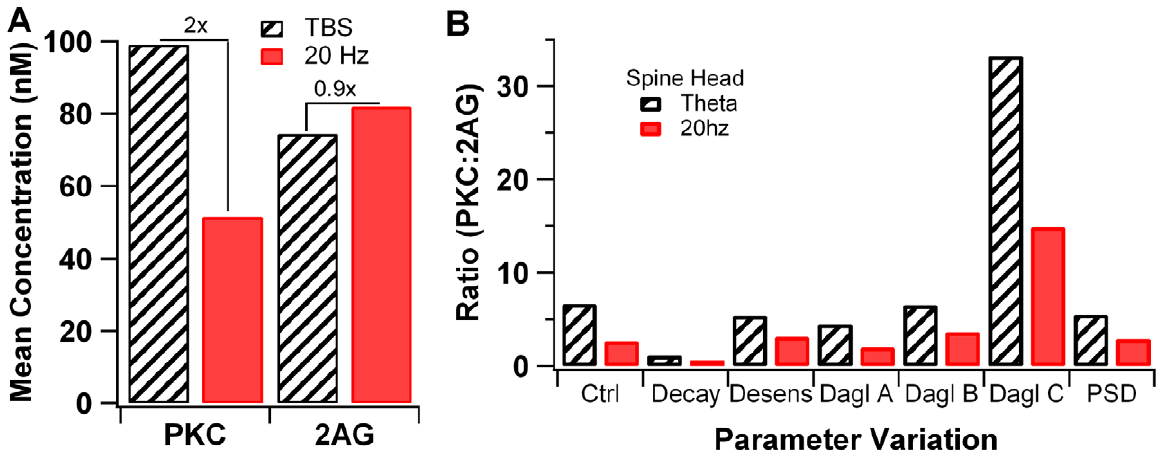
Figure 7. Summary of active PKC and 2AG production in response to theta burst and 20 Hz stimulation. (A) PKC is greater for theta burst stimulation than for 20 Hz stimulation, but 2AG is similar. Thus, the ratio of PKC to 2AG is greater for theta burst stimulation than for 20 Hz stimulation. (B) The enhanced ratio of PKC to 2AG for theta burst stimulation is observed for several different parameter variations. Decay: 2AG decay rate is 50% of control; Desens: mGluR desensitization is 50% of control; Dagl A: affinity of Dag Lipase for calcium is 50% of control; Dagl B: affinity of Dag Lipase for calcium is 200% of control; Dagl C: the affinity of Dag Lipase for Dag is 50% of control; PSD: molecules located in the spine head are added to PSD region. Additional parameter variations are illustrated in Fig